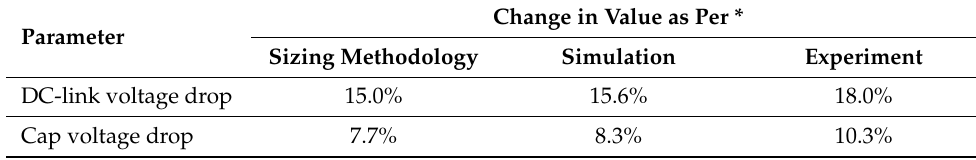
Table 5. Comparison of key parameters.